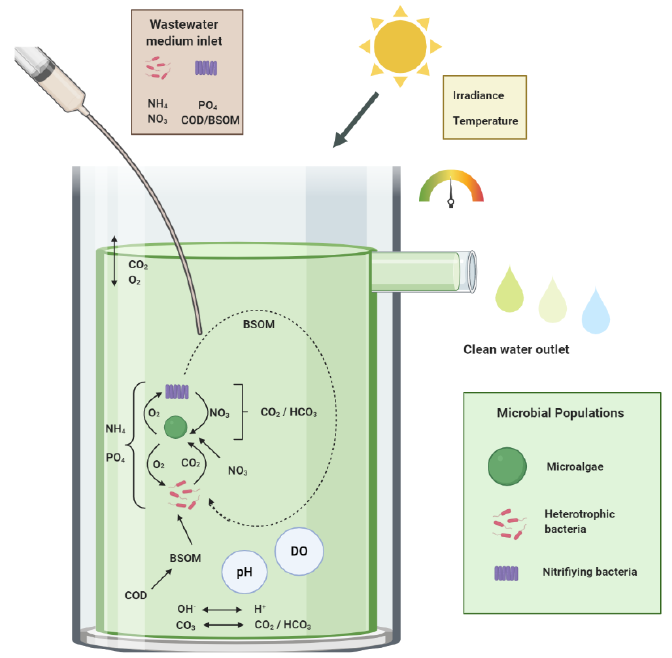
Figure 2. Biological process for microalgae biomass production coupled with wastewater treat-